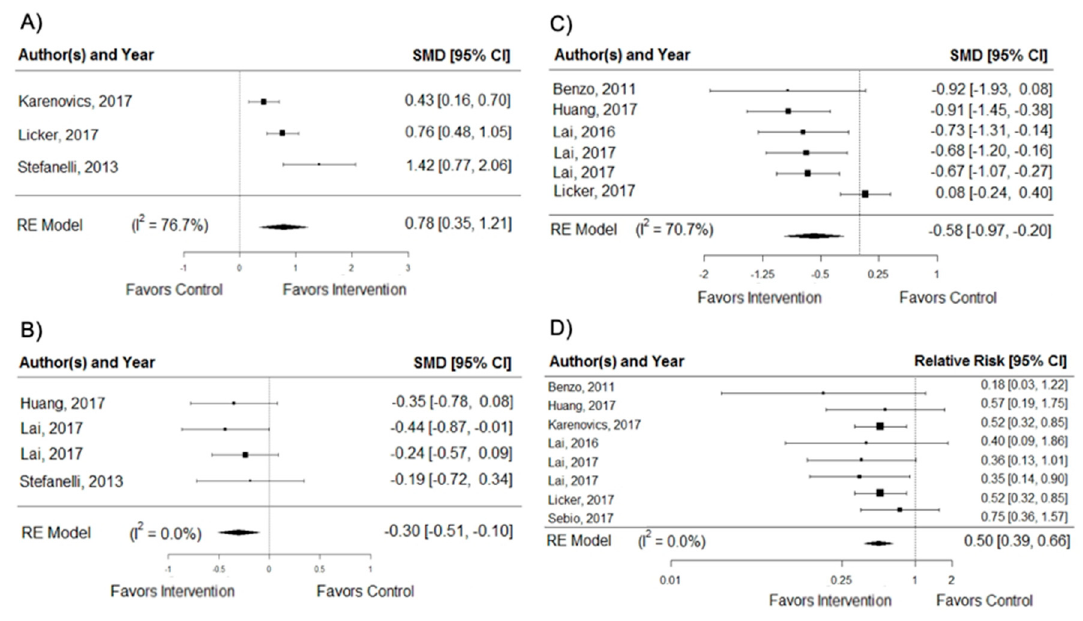
Figure 3. Pooled changes in secondary outcomes: ( A ) peak of oxygen consumption (VO 2 peak); ( B ) dyspnoea; ( C ) postoperative hospitalization (length of stay), and ( D ) postoperative pulmonary complications (PPCs). SMD = standardized mean difference; I 2 = heterogeneity; RE = random-effects models.